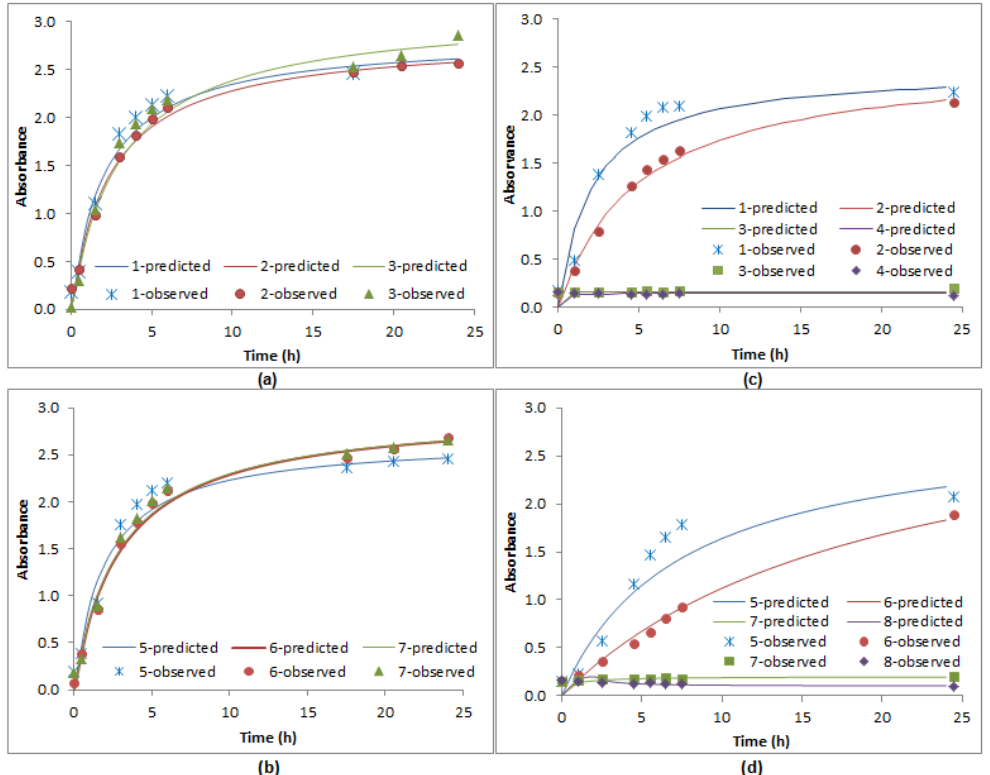
Figure 6. Effect of sugar types, ( a ) glucose or ( b ) xylose; sugar concentration, ( c ) xylose-50 g/L or ( d ) xylose-150 g/L; and ethanol concentration on E. coli KO11 growth, as measured by absorbance values (550 nm). Lines 1 to 3 and 5 to 7 in ( a ) and ( b ) are 0, 10, and 20 g/L ethanol concentrations in Luria-Bertani (LB) broths. Lines 1 to 4 and 5 to 8 in ( c ) and ( d ) are 0, 20, 50, and 100-g/L ethanol concentrations in LB broths. Sugar and ethanol concentrations, and regression parameters are presented in Tables 3 and 4, respectively. Table 3. Change in xylose and ethanol concentration in LB broth containing 50 or 150 g/L of xylose during E. coli KO11